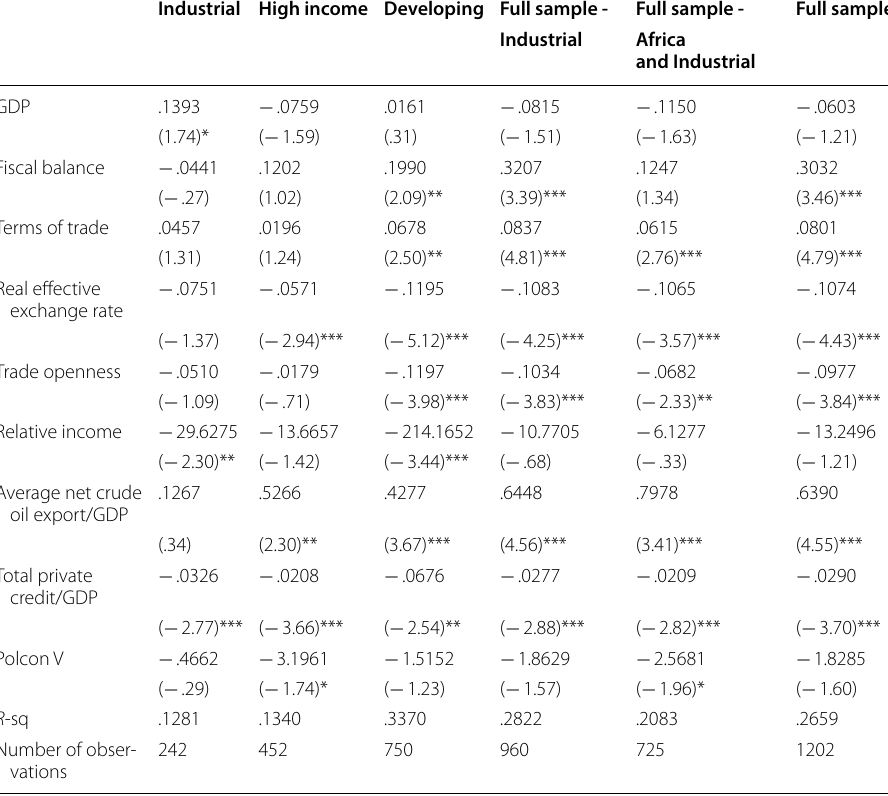
All variables are used in their first differences. t -statistics in parenthesis. *, **, *** indicate significance at 10%, 5%, 1%, respectively. The estimates for the constants are not